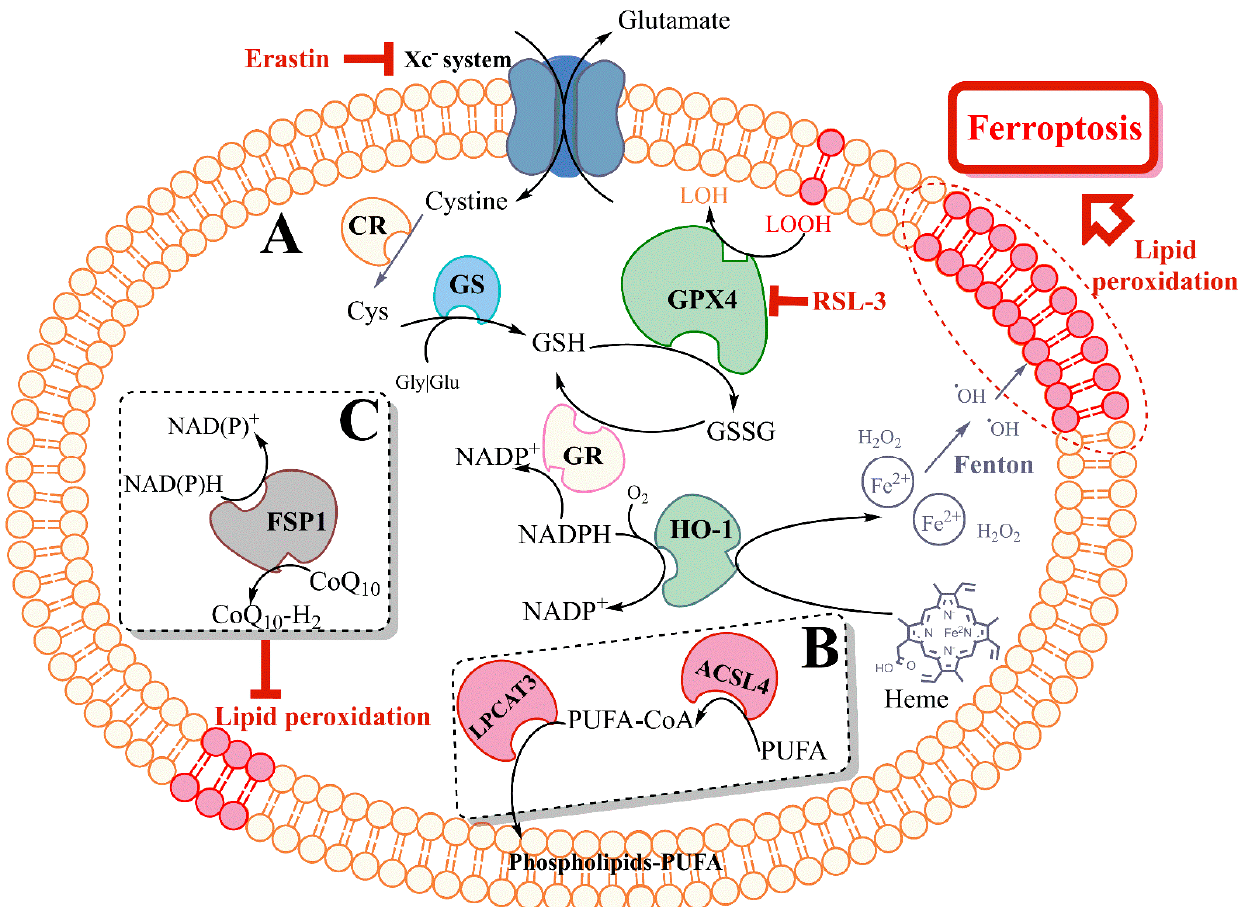
Figure 1. Pathways involved in ferroptotic cell death. ( A ) The cysteine-GSH-GPX4 system plays a central role in the cellular antioxidant mechanism and ferroptosis prevention. Inhibition of the Xc- system by erastin deprives the cells of cysteine, thus depriving them of GSH, triggering ferroptosis. Inhibition of GPX4 by RSL3 deprives the cells from the enzyme that reduces phospholipid peroxides (LOOH) to their corresponding alcohols (LOH), increasing lipid peroxidation and associated ferroptosis. Both erastin and RSL3 have been extensively used to induce ferroptosis in cell culture models. ( B ) The enzyme acyl-CoA synthetase long-chain family member 4 (ACSL4) activates highly oxidizable PUFAs, which is a critical step in their incorporation into phospholipids and into the cell membrane. Depleting the cells of ACSL4 increases the cellular resistance to ferroptosis. LPCAT3 catalyzes the incorporation of PUFA-CoA into phospholipids. Suppressing LPCAT3 activity increases resistance to ferroptosis. ( C ) FSP1 catalyzes the regeneration of CoQ 10 at the expense of NAD(P)H. CoQ 10 -H 2 (reduced form) is an effective lipid-soluble antioxidant, acting by directly reacting with free radical species in the membrane and preventing lipid peroxidation. CR, cystine reductase; GS, glutathione synthetase; GSH, reduced glutathione; GSSG, glutathione disulfide; GR, glutathione reductase; FSP-1, ferroptosis suppressor protein 1; CoQ 10 , coenzyme Q 10 ; HO-1, heme oxygenase 1; LPCAT3, lysophosphatidylcholine acyltransferase 3; PUFA, polyunsaturated fatty acid.